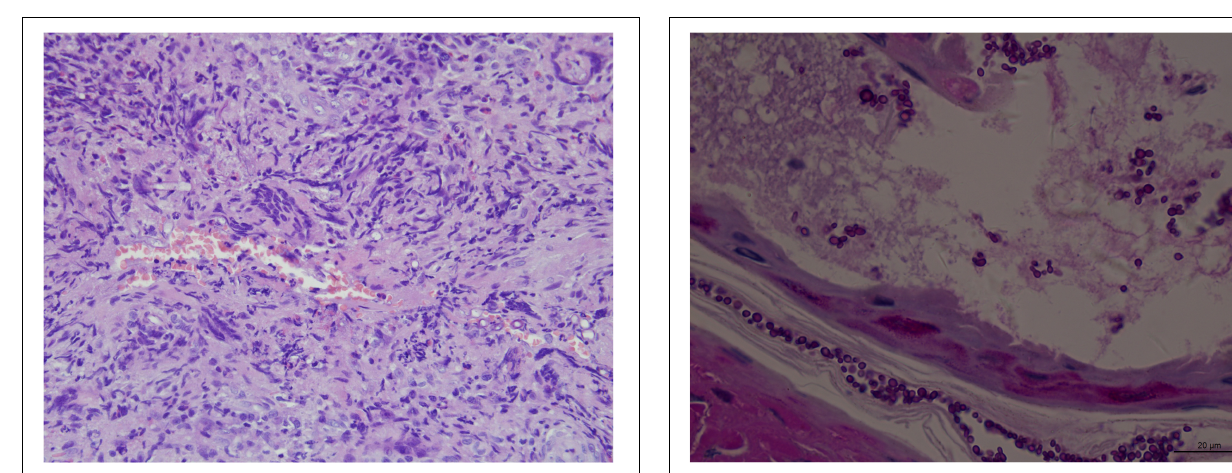
FIGURE 3 | Numerous spores of Aspergillus sydowii in the artery lumen and artery wall in rhino-orbital-cerebral mycosis (periodic acid-Schiff staining, original magnification × 1,000).